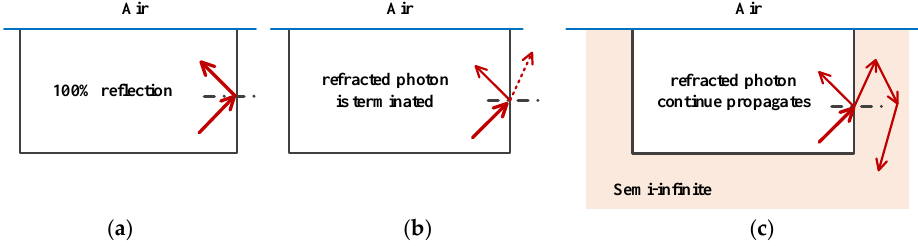
Figure 4. Three boundary conditions (BCs) for laser transportation. The computational domain is marked by a black rectangle. ( a ) Reflecting BC, ( b ) Escape BC and ( c ) Extended BC. The red dashed line represents the terminated photon.